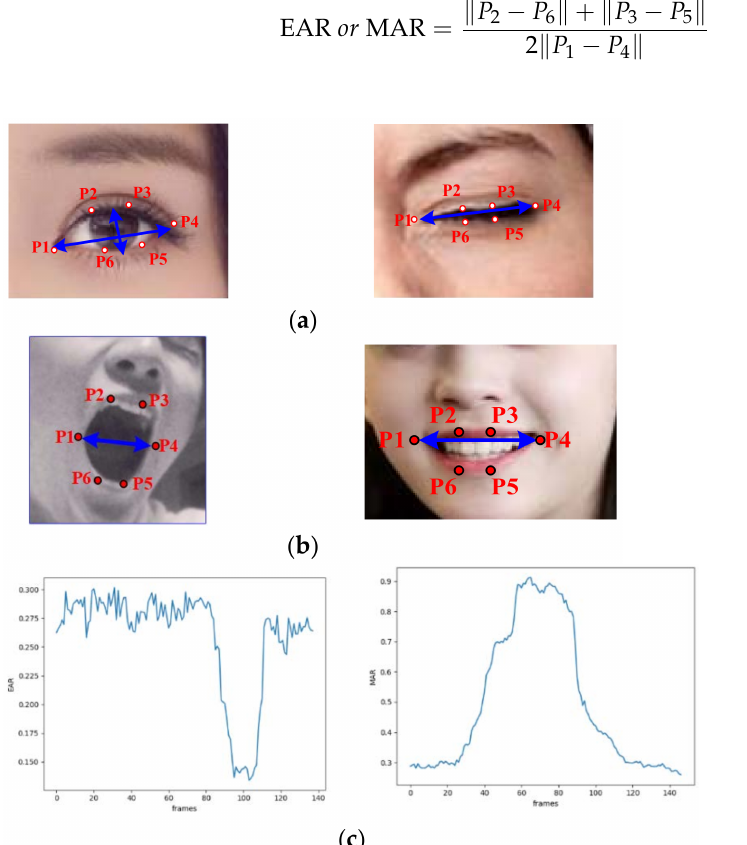
Figure 5. Eyes or mouth landmarks and the values of EAR/MAR; ( a ) eyes landmarks have significant differences (open or closed); ( b ) mouth landmarks have significant differences (open or closed); and ( c ) the values of EAR or MAR at open and closed